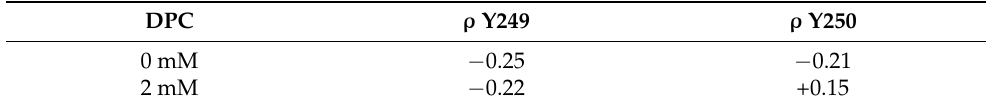
Table 2. ρ = integral (H δ )/integral (H ε ) for Y249 and Y250 residues (calculated from integral values shown by Figures S9 and S10) of LytA 239–252